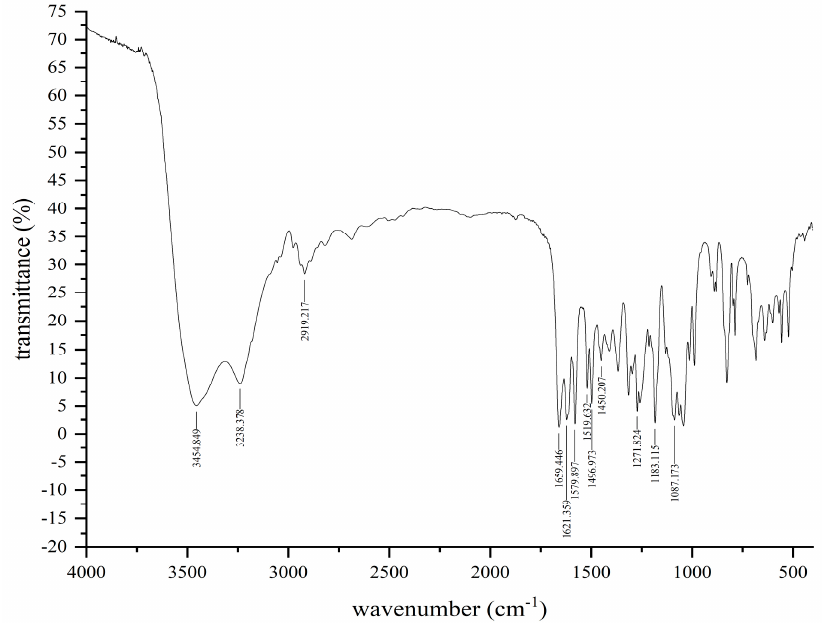
Figure 5. FT − IR scanning of extract